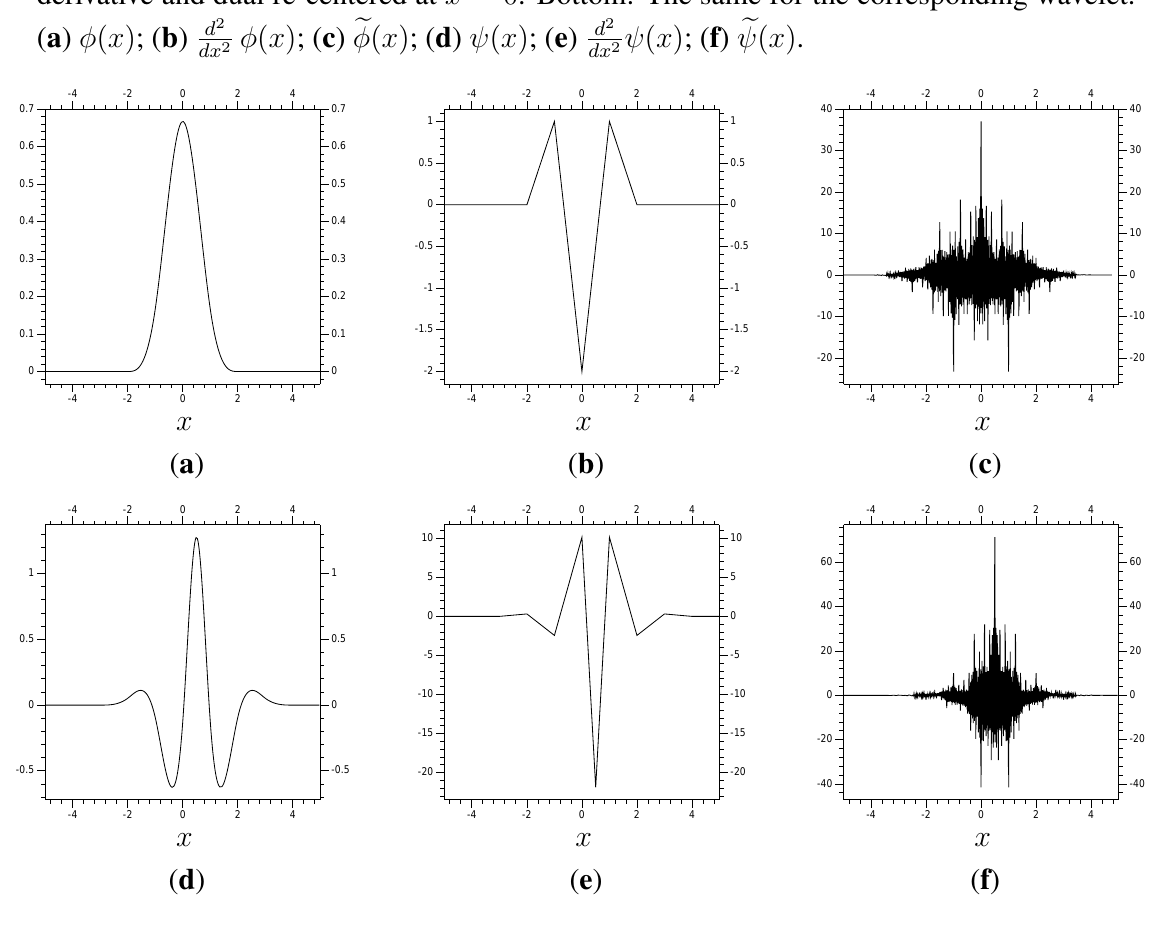
Top: The wavelet pair corresponding to the spline function B derivative and dual re-centered at x = 0 . Bottom: The same for the corresponding wavelet. e ϕ ( x ) ; ( c ) ϕ ( x ) ; ( d ) ψ ( x ) ; ( e ) d 2 ( a ) ϕ ( x ) ; ( b ) d 2 dx 2